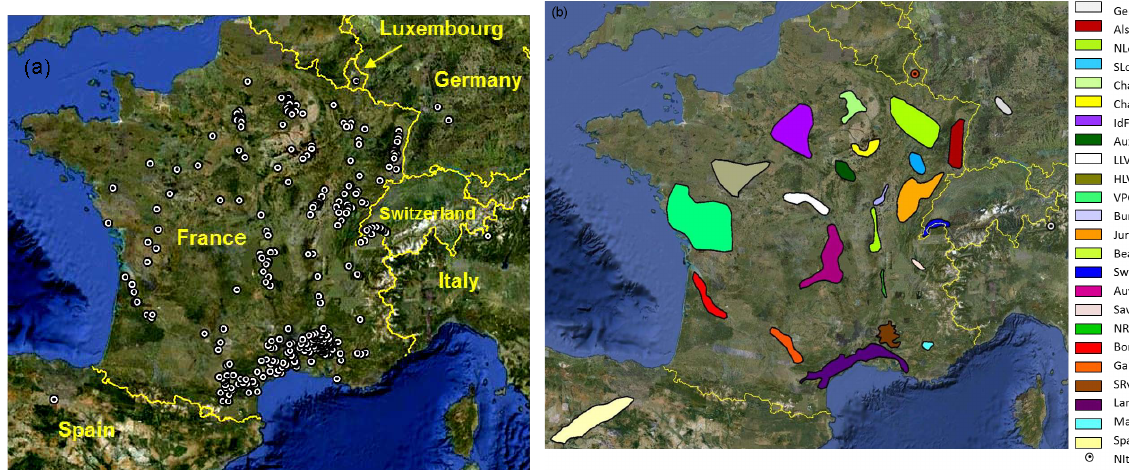
Fig. 1. (a) Location of GHD sites and (b) of the regions defined in Table 1. “Various south east” field is not reported. It corresponds to the series in south-eastern France which cannot be classified in Languedoc, in Maritime Alps or in Southern Rhˆone